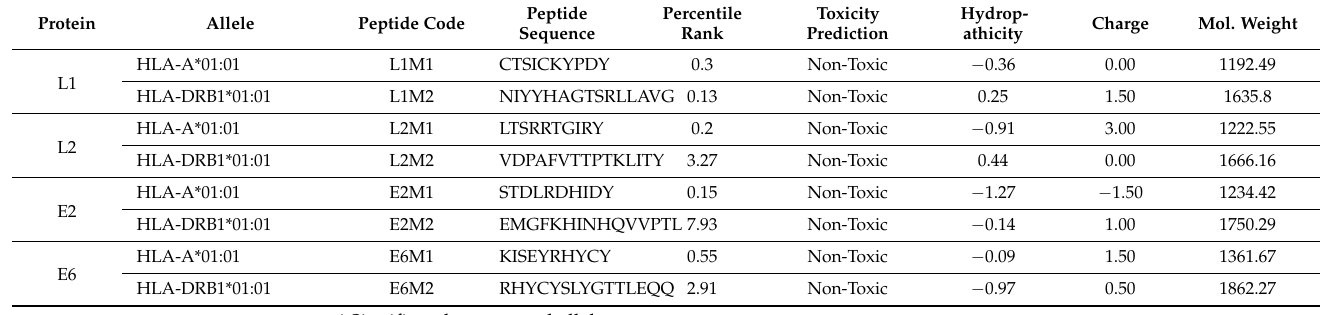
Table 1. Predicted MHC class I and II specific epitopes of HPV antigenic proteins and their physio- chemical properties.